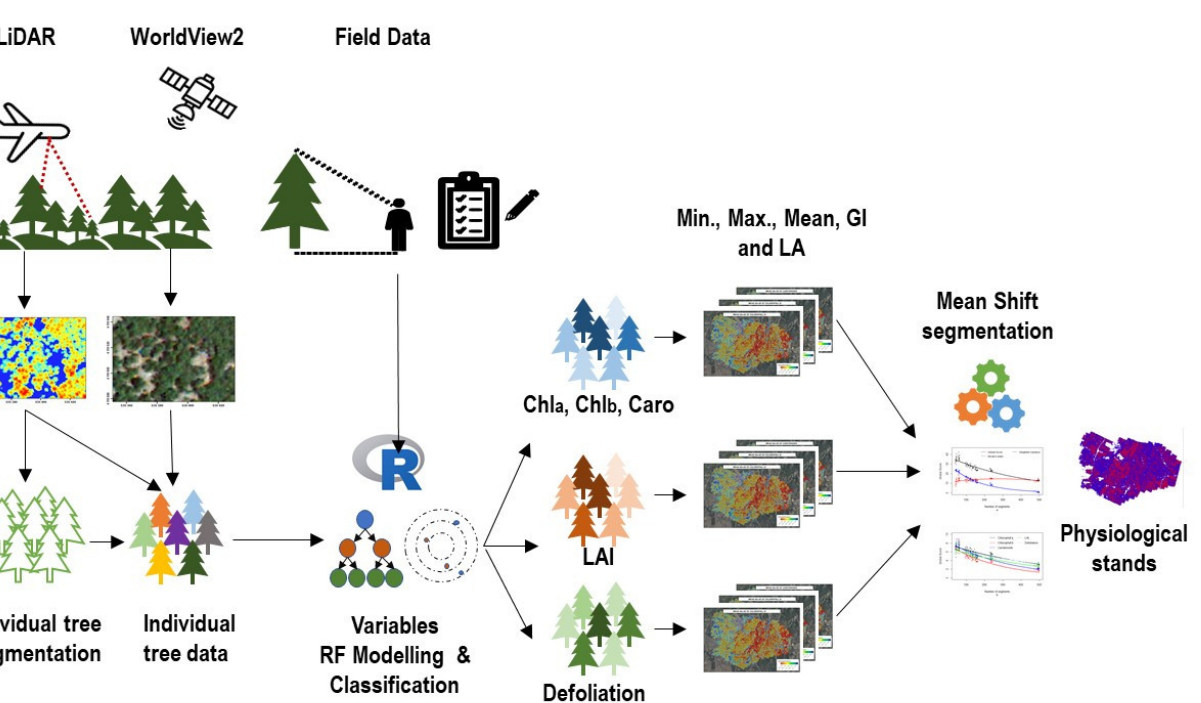
Figure 1. Overview of the proposed workflow to derive stand segmentation based on tree health information from World View-2 multispectral and LiDAR data on southeastern Andalusia Pinus sylvestris forests .